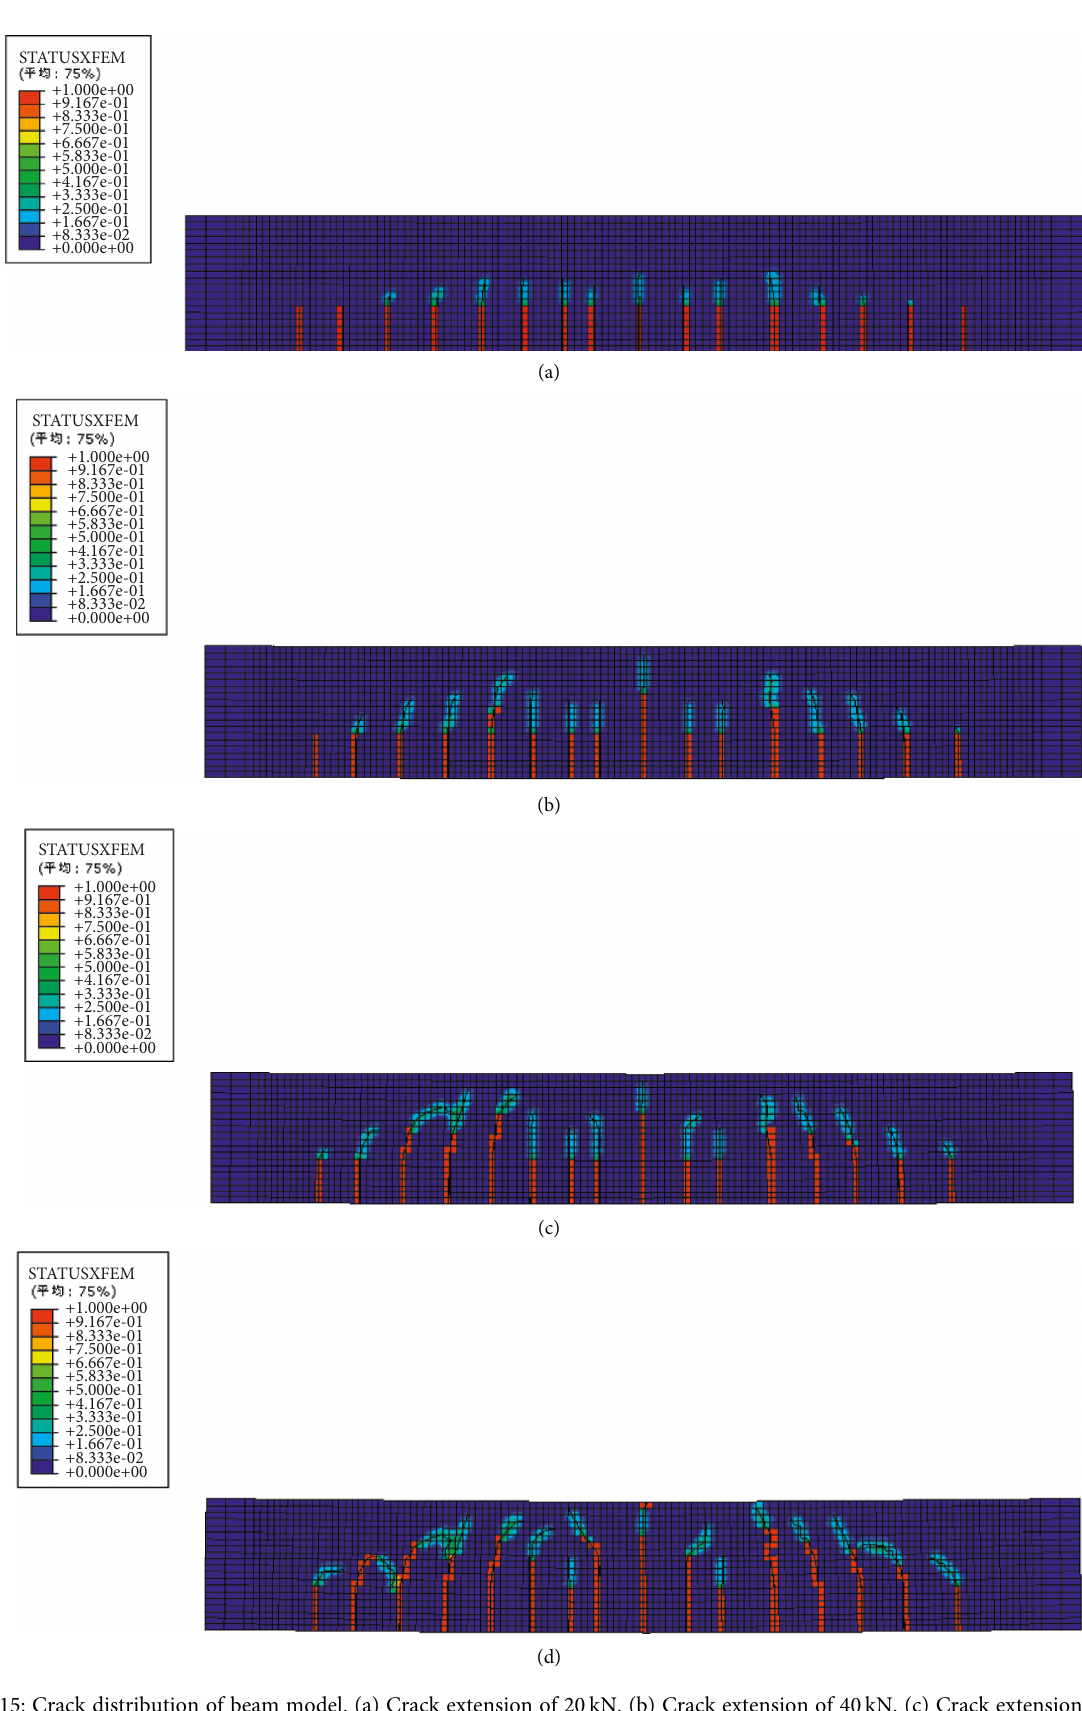
Figure 15: Crack distribution of beam model. (a) Crack extension of 20kN. (b) Crack extension of 40kN. (c) Crack extension of 60kN. (d) Crack extension of